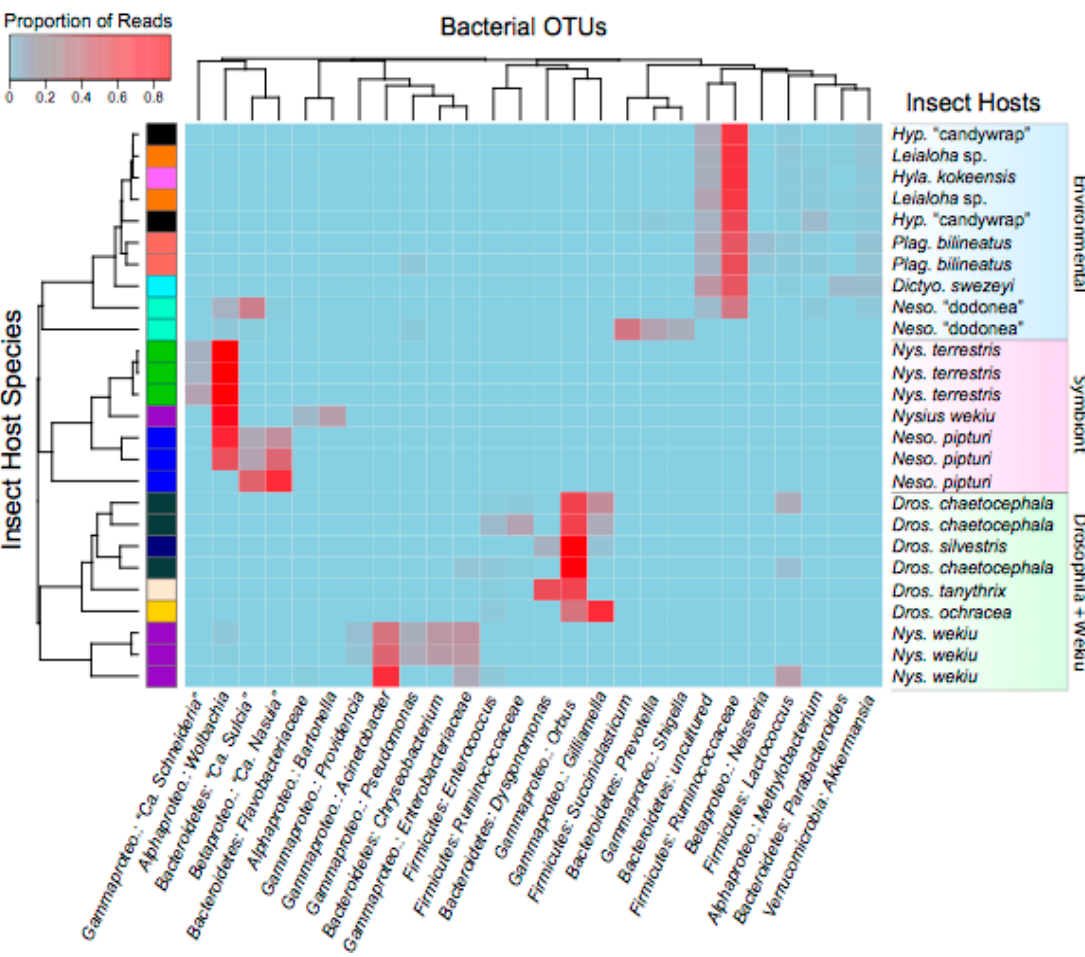
Figure 2. Heatmap showing bacterial taxa distributed across sequenced insect specimens. Bacterial OTUs that comprise less than 5% of total reads are excluded. Cell values are calculated proportionately across rows and dendrograms estimated with Bray–Curtis dissimilarity index. Clusters shown on the right side in shaded boxes (e.g., Environmental, Symbiont, etc.,) correspond to those also shown Figure 1a (ANOSIM: R = 0.94, p = 0.001). Some bacterial taxonomic names (e.g., Betaproteo . = Betaproteobacteria ) have been abbreviated.